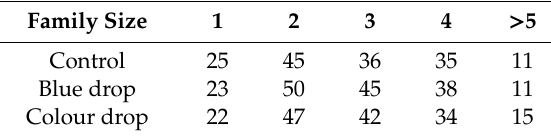
Table 1. Distribution of family size in each group.